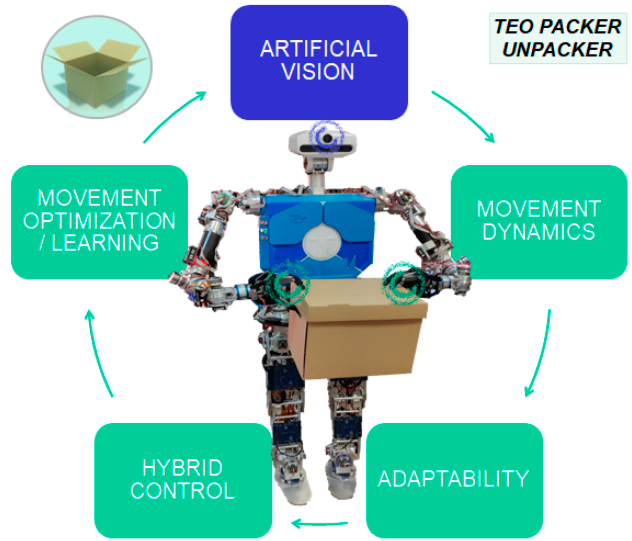
Figure 1. General scheme of the application of the TEO packer/unpacker.